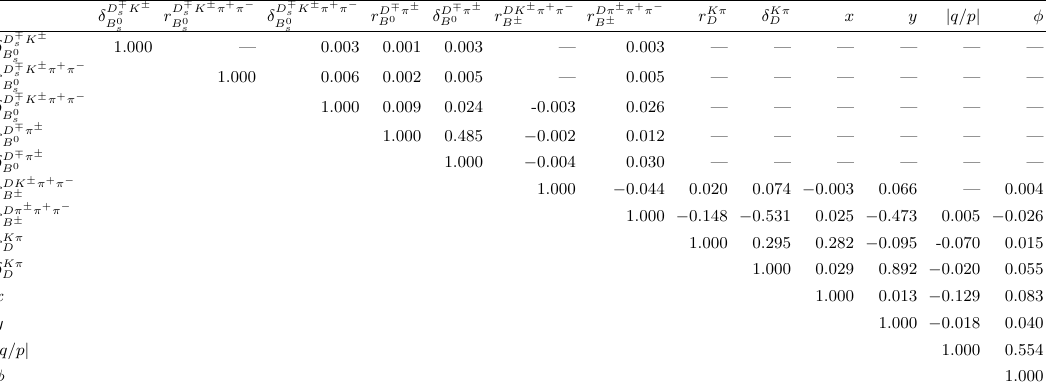
Table 9 . Correlation matrix of the fit result, part 3 of 3. Values smaller than 0 . 001 are replaced with a —